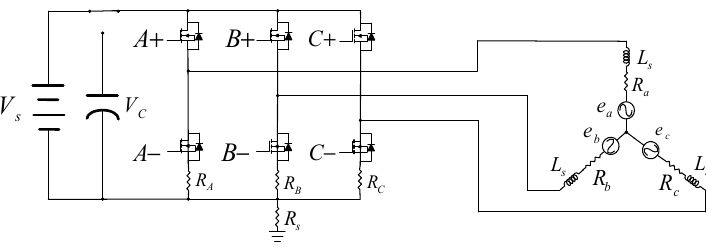
Figure 3. Circuit diagram as the system stays in driving mode.